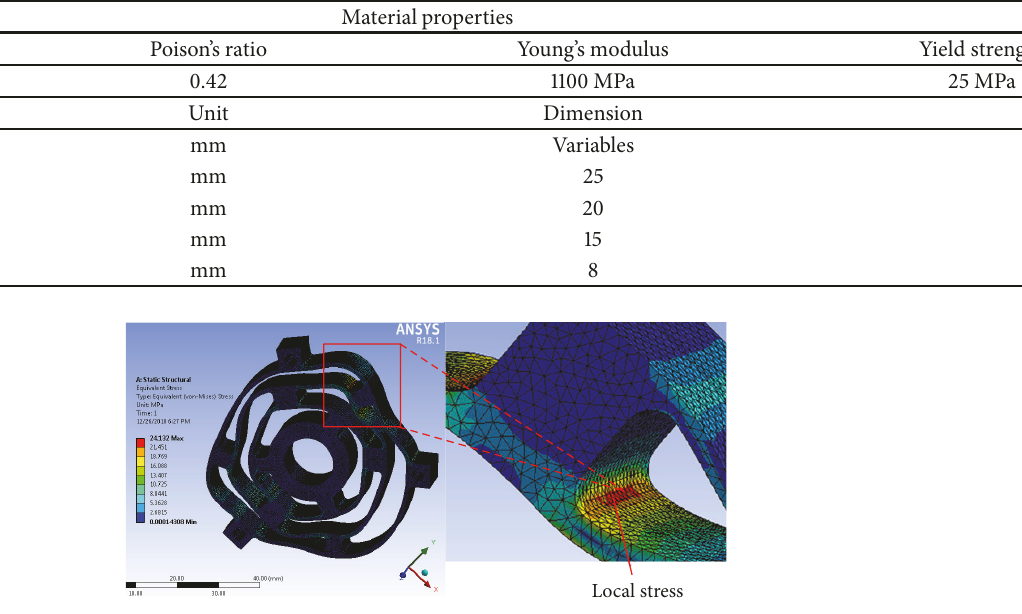
Figure 4: Distribution of stress and deformation of the joint.